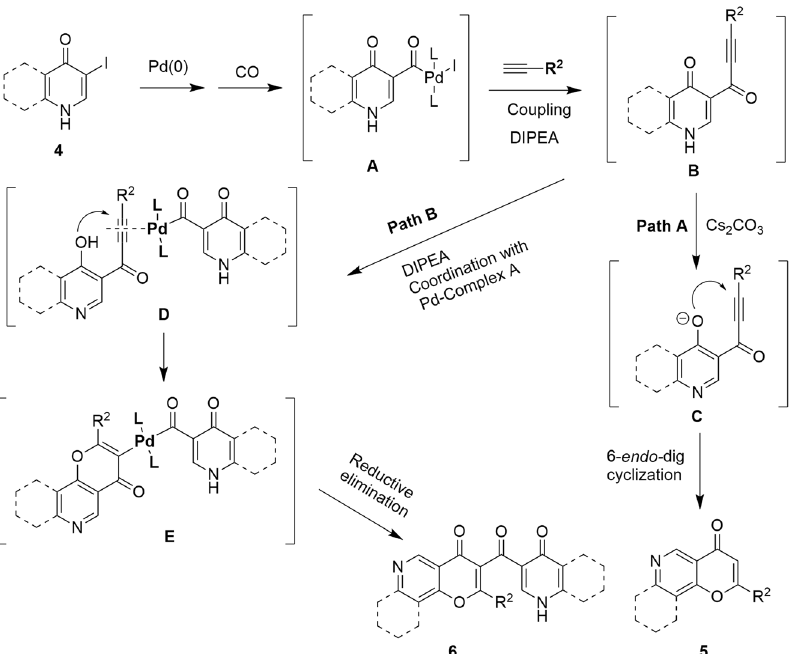
Figure 5. Plausible mechanism for the generation of product 5 and 6 .